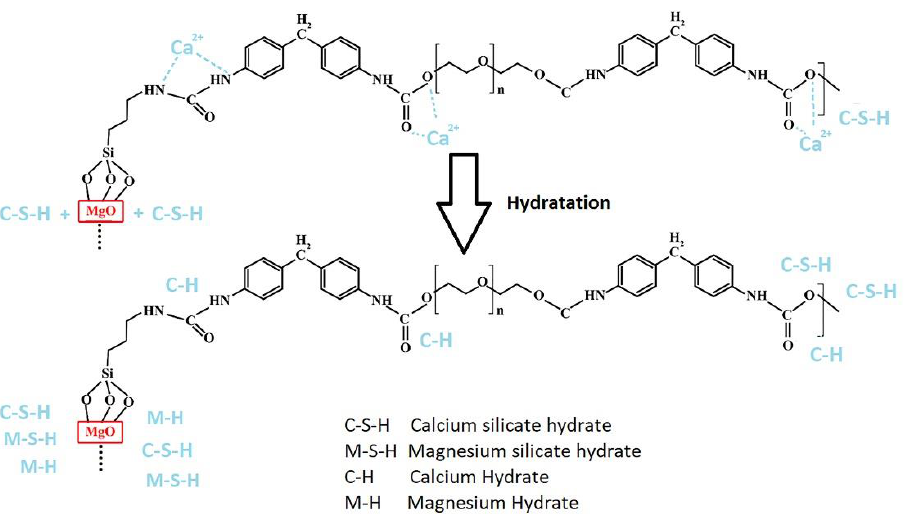
Figure 11. Mechanism of the effect of nanohybrids on cement hydration products.